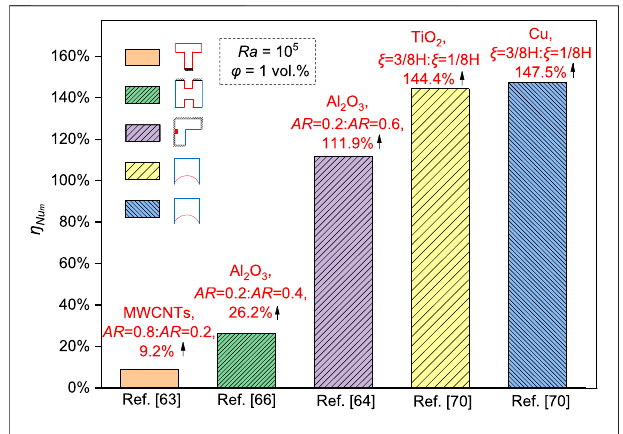
FIGURE 6 | Increments of average Nusselt numbers of nano fl uids in various cavities with the optimal and the worst aspect ratios.